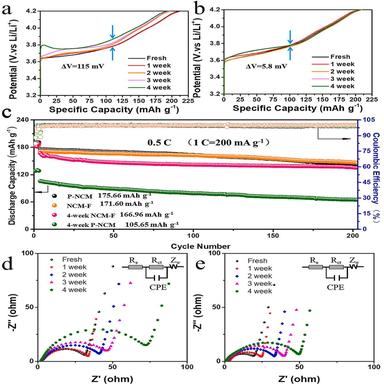
The first charging profiles of (a) P-NCM and (b) NCM-F before/after air aging; (c) Cyclic performance comparison of P-NCM and NCM-F before/after air aging; (d-e) EIS curves of P-NCM and NCM-F samples during air aging tests. Insets are equivalent circuit models.